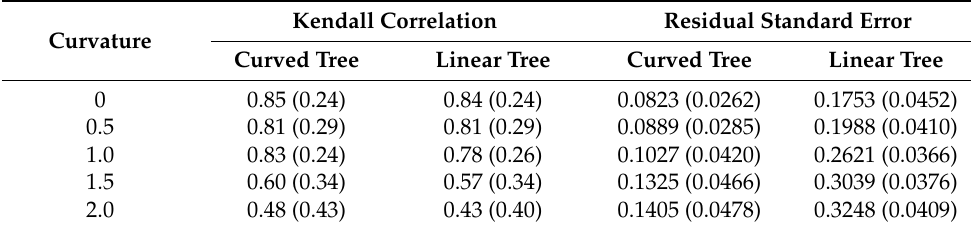
Table 2. Mean Kendall correlations and mean residual standard error for both curved tree algorithm and linear tree algorithm with different